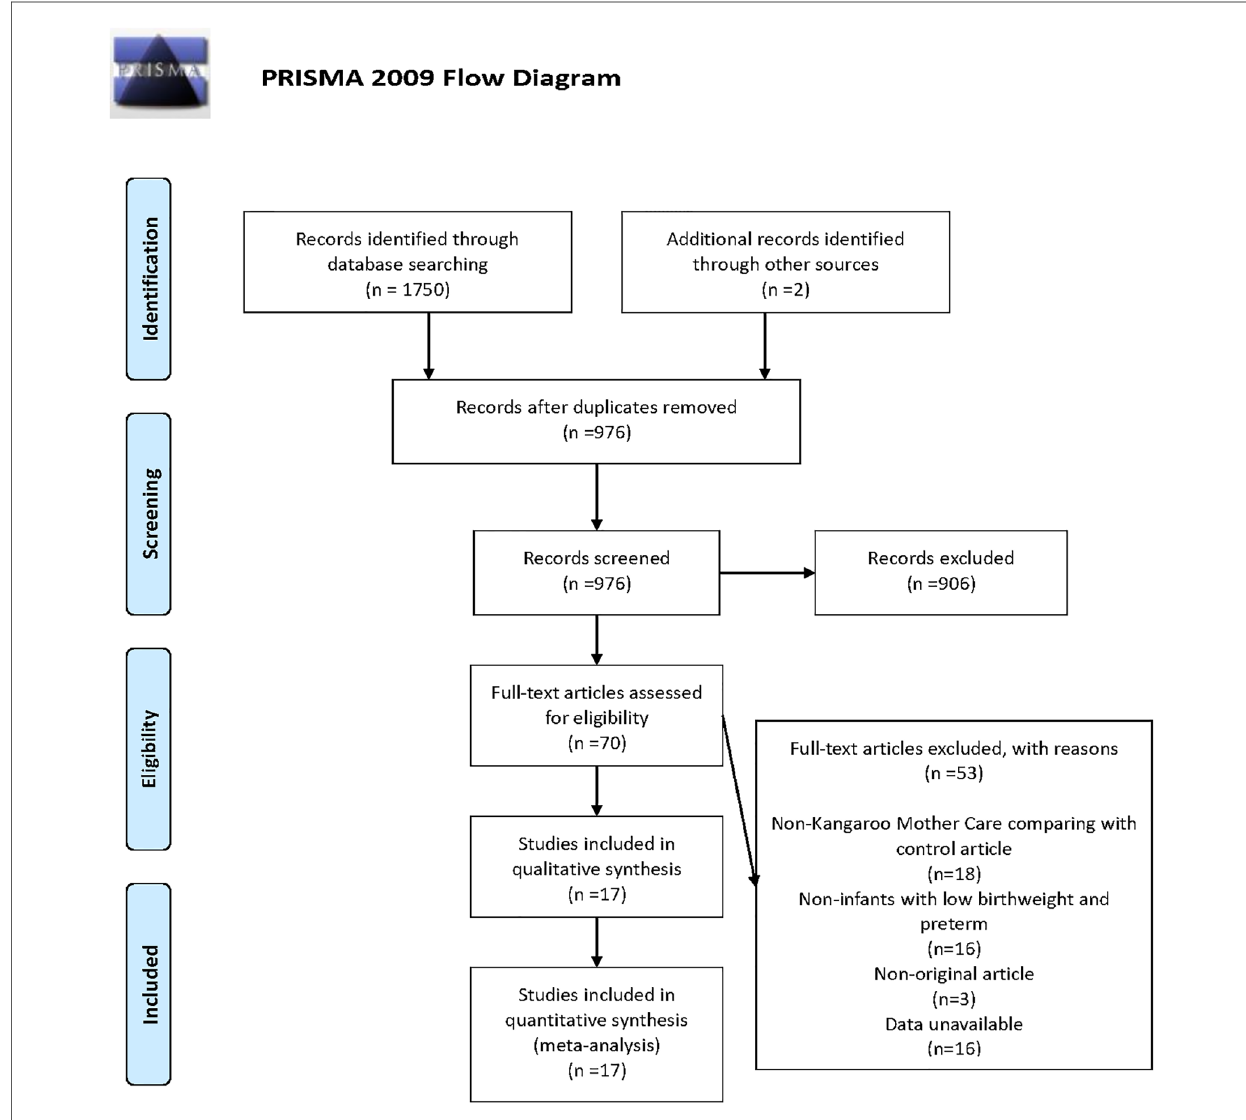
FIGURE 1 Flow diagram of study inclusion and